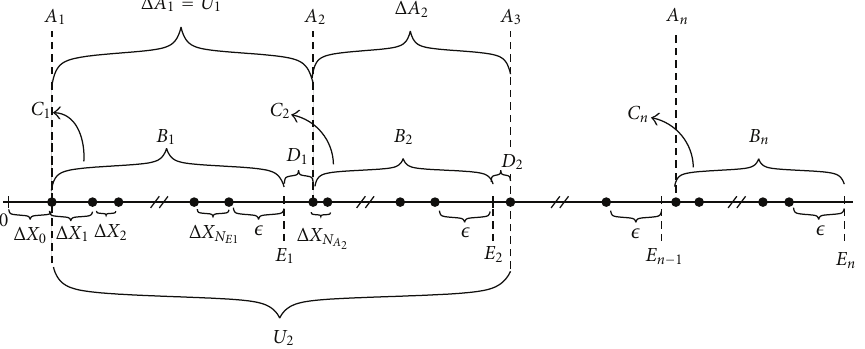
Figure 2: Definitions of the relevant quantities of the network. Distance between points, distance between clusters, clusters size, interclusters size, beginning and ends of